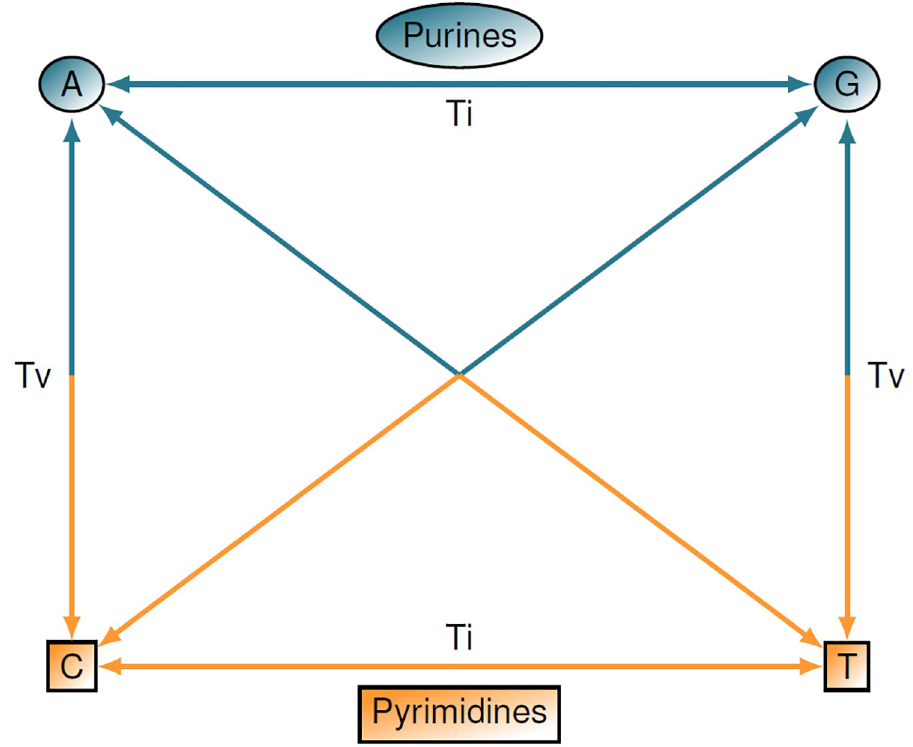
Fig 5. Purines (A and G) and pyrimidines (C and T) are shown. Transitions occur when a mutation involves purine- to-purine or pyrimidine-to-pyrimidine insertion. Transversions occur when a purine-to-pyrimidine or pyrimidine-to- purine insertion happens, which is a more extreme case. There are visibly more possibilities for transversions to occur than there are transitions, but there are about twice as many transitions in real